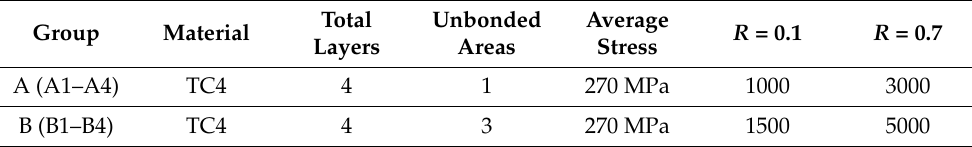
Figure 3. The loading spectrum. Table 2. The type of the specimens and the loading information.